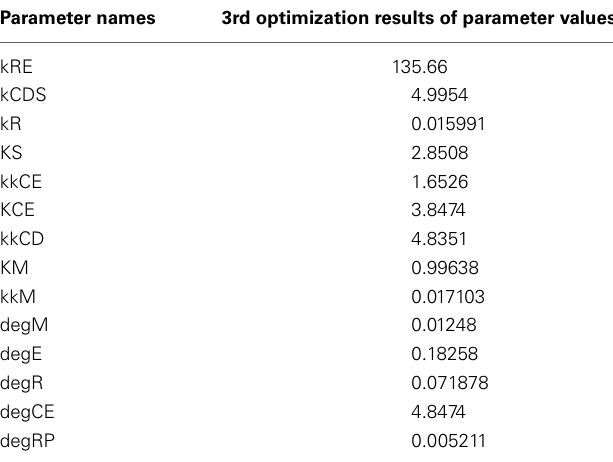
Table 3 | Results of the third